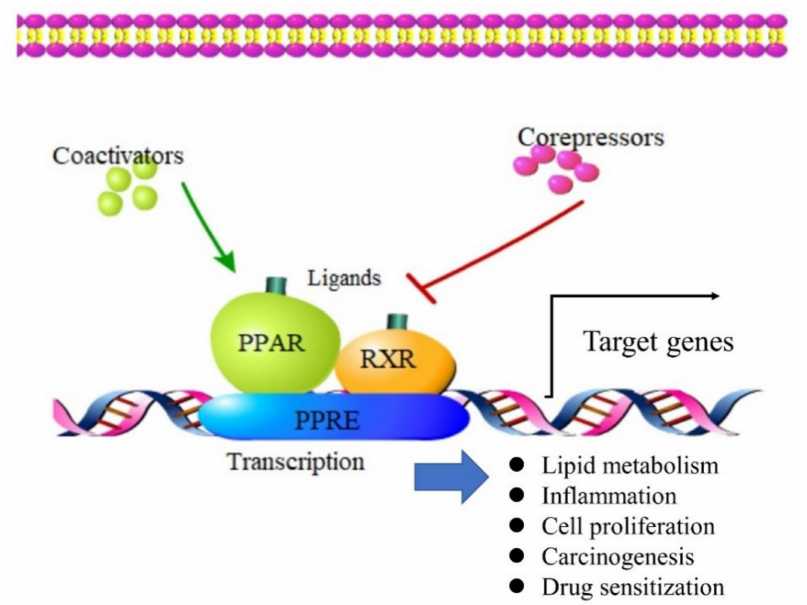
Figure 1. Interaction between PPARs and PPRE. The figure shows PPAR structure and related coactivator, and corepressor molecules involved in activation (green arrow) and repression (red arrow) mechanisms. The activation signaling of PPAR-RXR heterodimer and PPRE allows the expression modulation of target genes to affect various biological